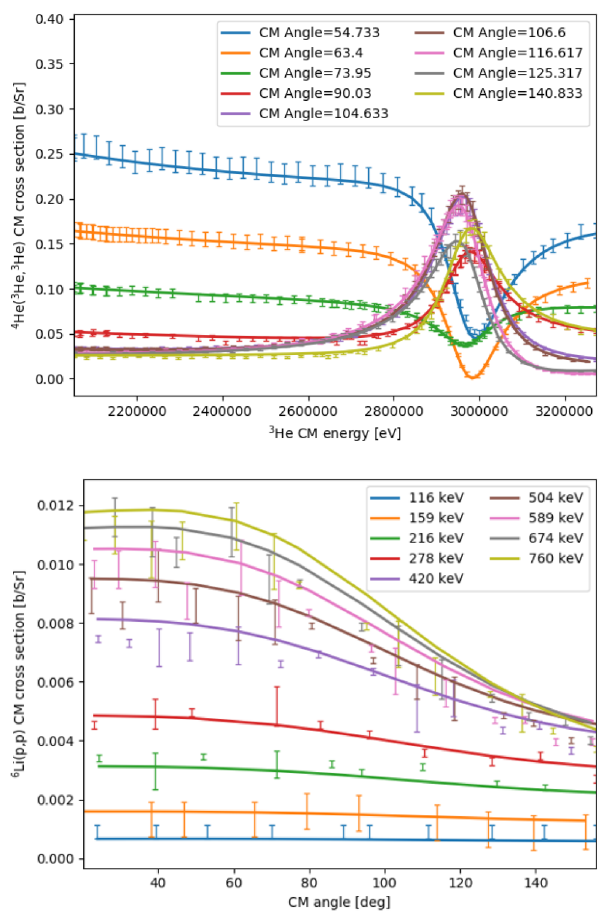
Fig. 13. Simultaneous analysis of measurements involving the same compound system. Up is the comparison of CONRAD on Barnard 1964 4 He( 3 He, 3 He) measurements. Bottom is the comparison of CONRAD (with the same model than previously) on Fasoli 1964 6 Li ( p, p )